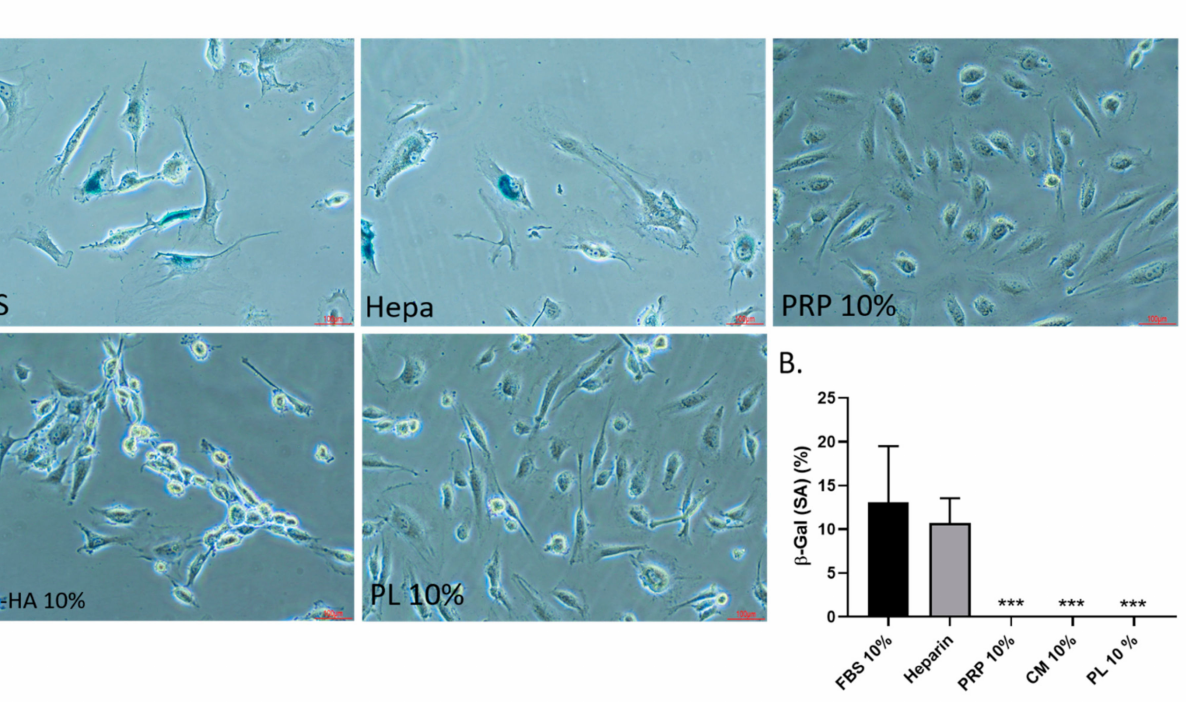
Figure 5. Senescence associated beta-galactosidase (SA- β -gal) staining of HUVECs. (20 × objective lenses) at passage 6 treated with FBS, Heparin, 10% PRP, 10% PRP-HA or 10% PL as indicated in the figures. Beta-gal positive cells appear in blue in FBS and heparin culture conditions ( A ). Proportion of SA- β -gal positive HUVECs in A-E culture conditions. *** p < 0.005 ( B